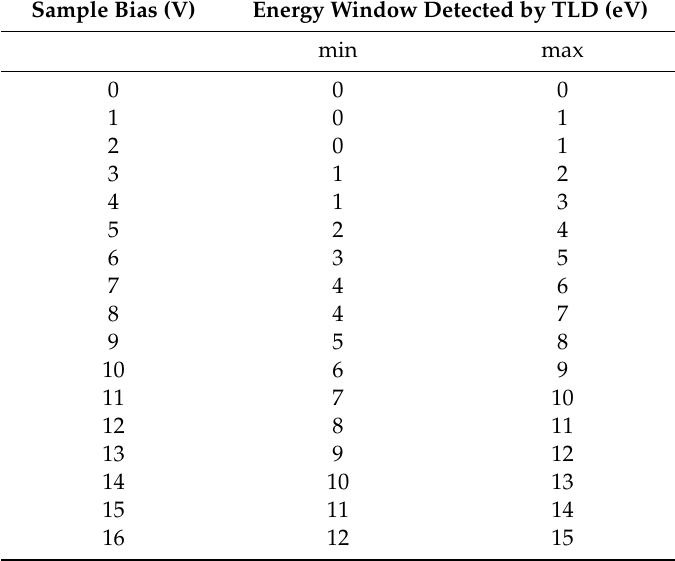
Table 2. The emission energy of SEs detected by the TLD for sample bias 0, 4, 8, 12 and 16 V, working distance WD = 1 mm, primary beam energy E P = 1 keV (data from the graph in Figure 5).